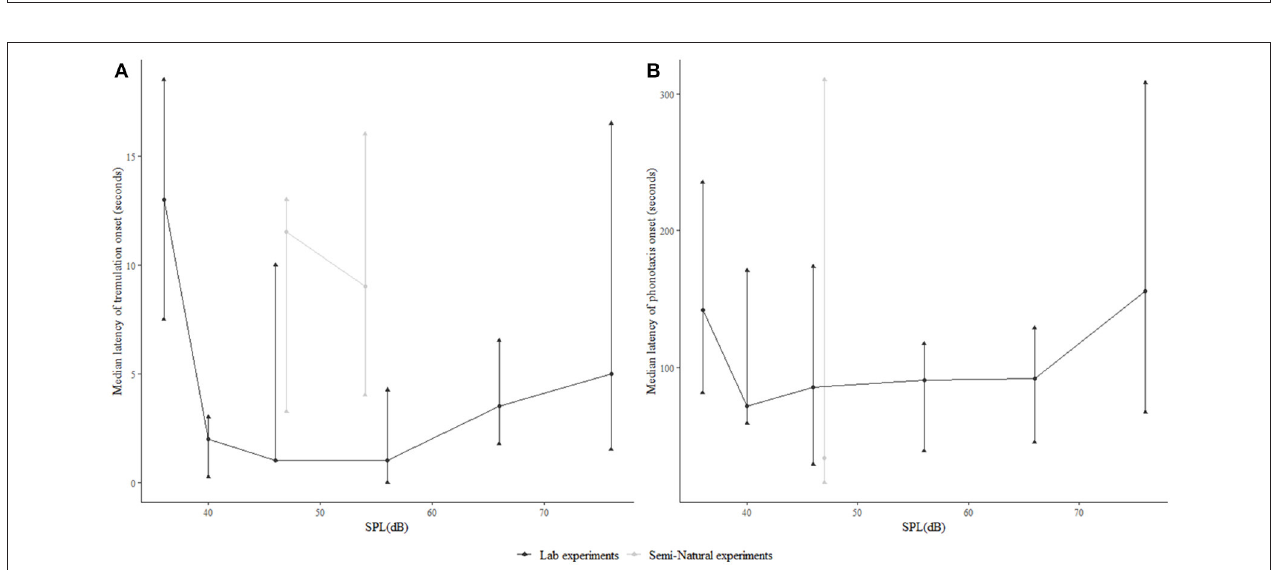
FIGURE 4 | Relationship of the latency of (A) onset of female tremulation and (B) the onset of female phonotaxis after song onset, in the laboratory as well as semi-natural settings, relative to stimulus SPL.